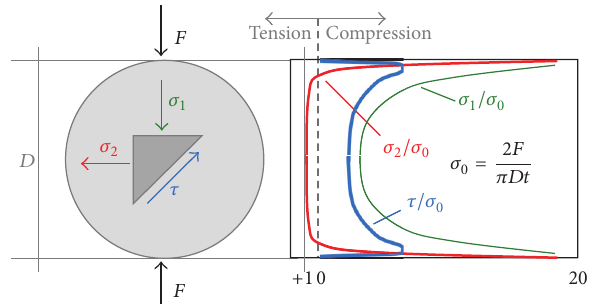
Figure 1: Qualitative stress state distribution developed in the specimen during a Brazilian